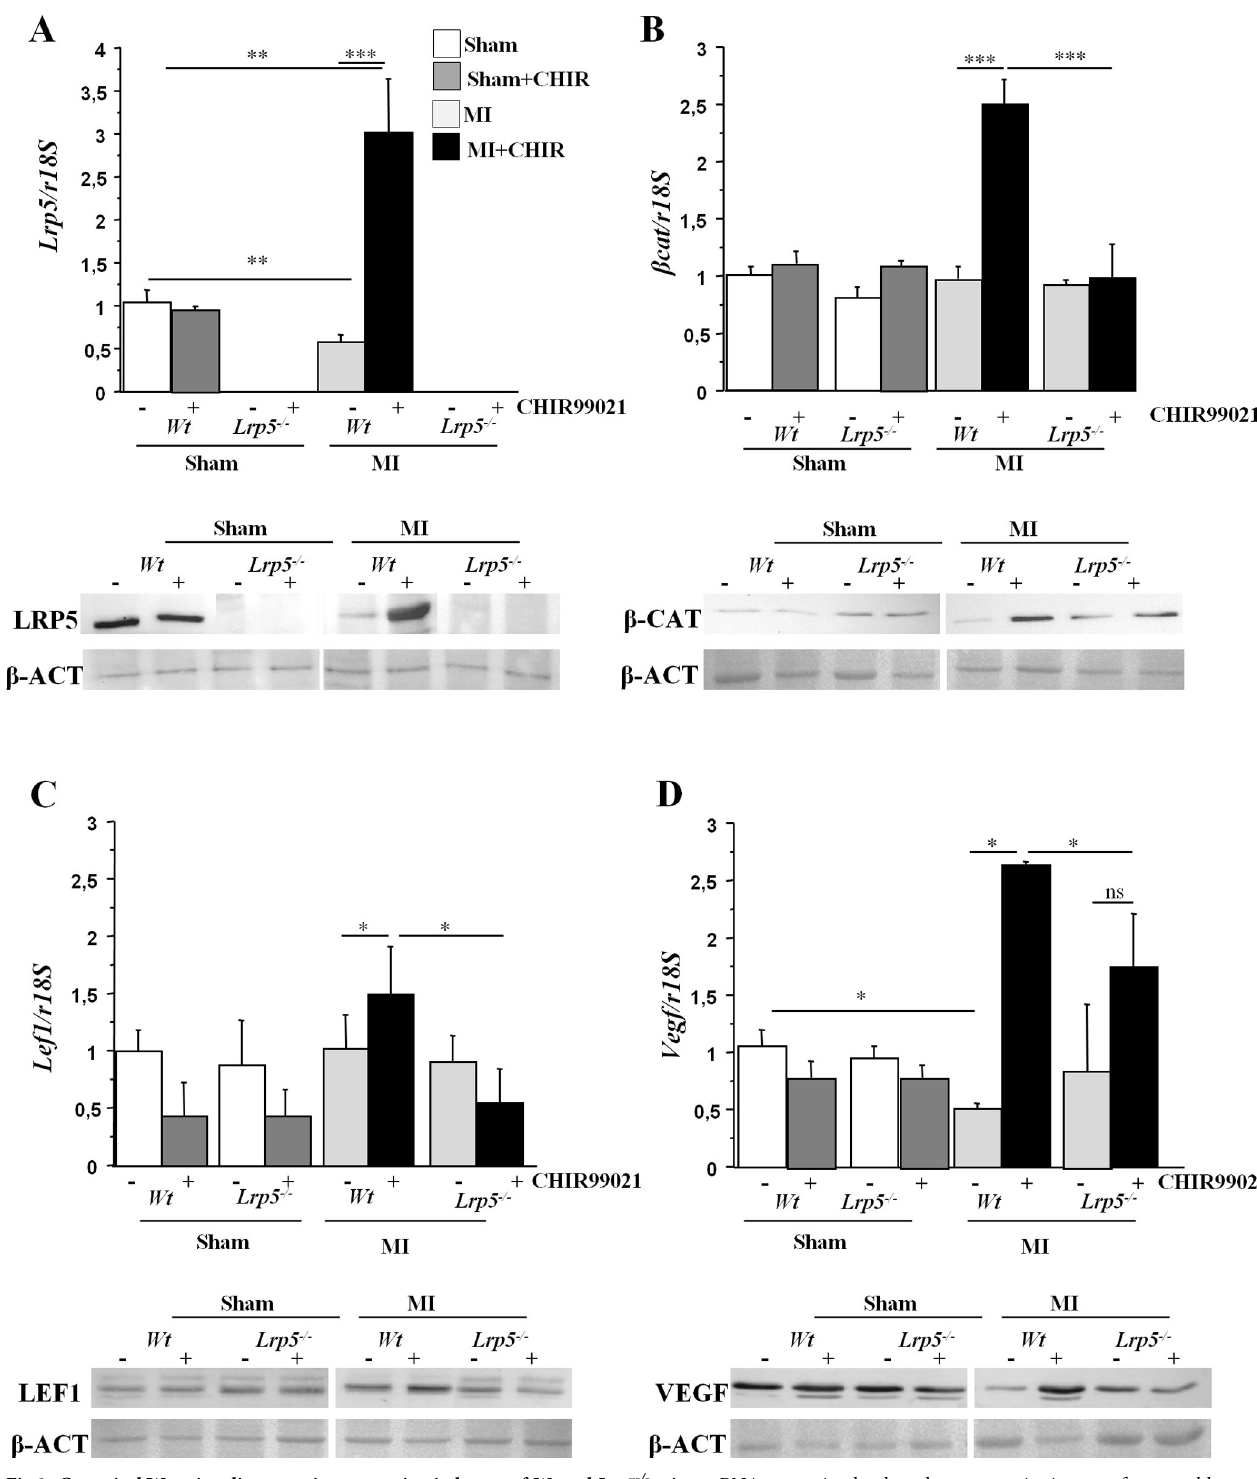
Fig 2. Canonical Wnt signaling proteins expression in hearts of Wt and Lrp5 -/- mice. mRNA expression levels and representative images of western blots showing protein expression levels of (A) Lrp5 , (B) β -catenin , (C) Lef1 and (D) Vegf in hearts of Wt and Lrp5 -/- mice. 6–10 male mice /condition � p < 0,05; �� p < 0,01; ��� p < 0,005; ns: non significant.